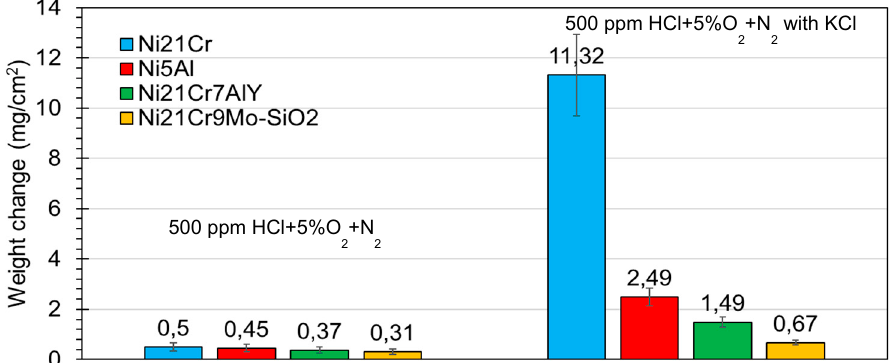
Figure 4. Weight change of the HVAF-sprayed Ni 21 Cr, Ni 5 Al, Ni 21 Cr 7 AlY, and Ni 21 Cr 9 Mo-SiO 2 coatings in HCl-laden environment at 600 °C after 168 h exposed with and without KCl.